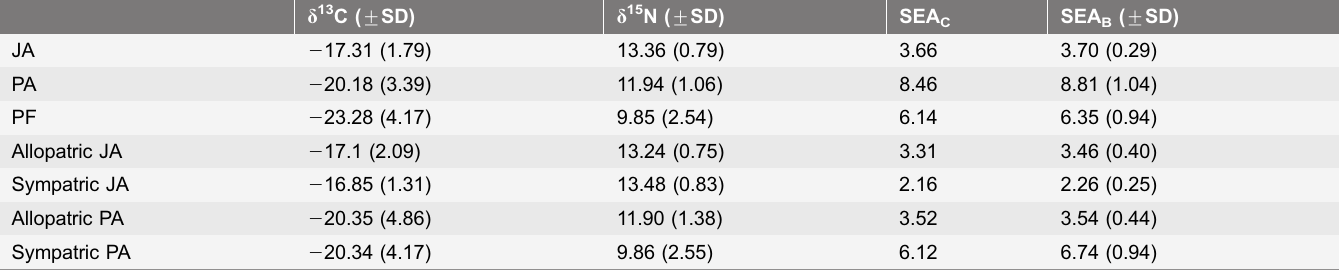
Table 2. Isotope niche metrics for allopatric and sympatric forms; SEA C 5 corrected Standard Ellipse Area, SEA B 5 Bayesian Standard Ellipse